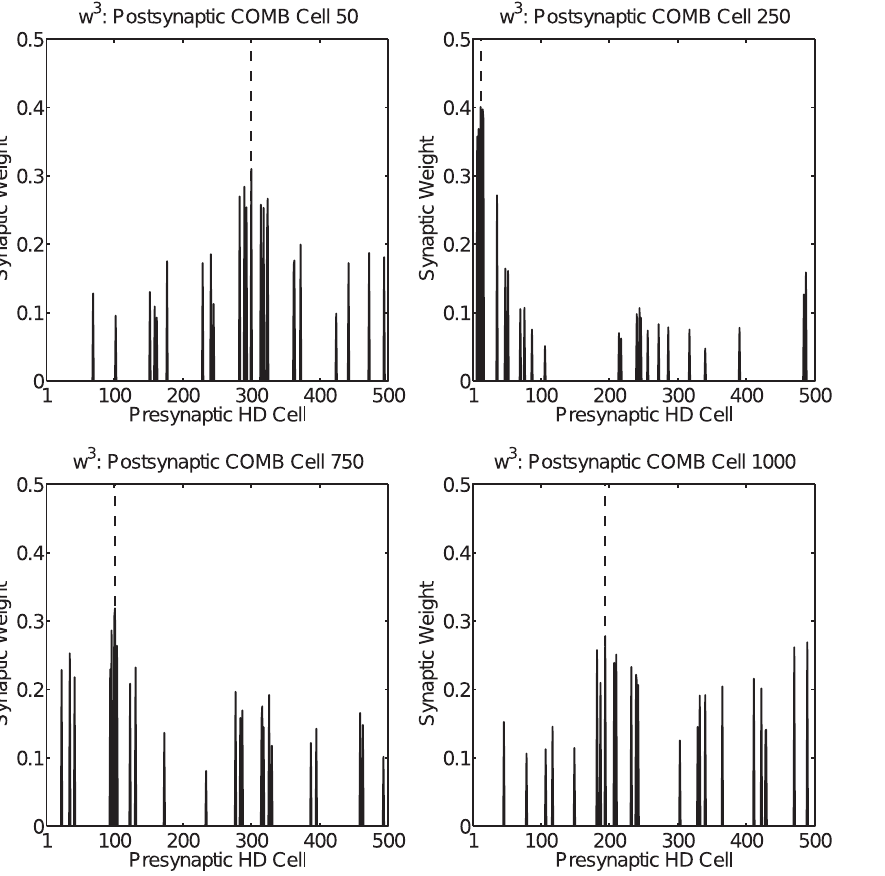
Figure 4. The synaptic weights w 3 from the Head Direction (HD) cell network to the Combination (COMB) cell network after competitive learning with the time-delayed Hebbian associative learning rule (9) and weight normalization (13). These results are from a simulation with an axonal conduction delay of 100 ms, and a rotational velocity during training of 180 0 = sec (all other parameters are as given in Table 1). Each of the four plots shows the learned synaptic weights to a different postsynaptic COMB cell from the 500 presynaptic HD cells. The presynaptic HD cells are arranged in the plots according to where they fire maximally in the head-direction space of the agent when visual input is available. For each plot, a dashed vertical line indicates the presynaptic HD cell with which the postsynaptic COMB cell has maximal w 3 synaptic weight. Except for the effects of diluted synaptic connectivity, each of the weight profiles is centred on a region of similarly-tuned HD cells, with a profile that is approximately symmetric about the presynaptic HD cell with maximal synaptic strength. Thus, the learned w 3 synaptic weights show that individual COMB cells learn to receive maximal stimulation from particular head direction cells. Given that the model parameters w 3 , w 4 , and the threshold a of the COMB cell sigmoid transfer function are tuned to ensure that a strong rotational velocity cell input through the w 4 synapses is also needed in order to fire the COMB cells, these cells in fact learn to respond to combinations of a particular head direction and clockwise or counter- clockwise rotational velocity. input. During the time interval 0.0–2.25 seconds, the agent rotated (compared to the w 3 synapses), the activity packet in the in a clockwise direction. During the time interval 2.25–4.5 combination cell network stimulated head direction cells repre- seconds, the agent rotated in a counter-clockwise direction. The senting head directions further along in the clockwise direction of top right plot displays the firing rates of the head direction cells rotation. Thus the head direction cell activity packet moved during testing in the absence of visual input. During the time through the head-direction space of the agent, and the model interval 0.0–1.0 seconds, there was no firing in the rotational performed velocity path integration of head direction. During the velocity cells (bottom left plot) and consquently no firing in the time interval 2.0–3.0 seconds, the rotational velocity cells, and thus combination cells (bottom right plot); thus there was a stable the combination cells, were quiescent in their firing and a stable packet of head direction cell activity supported by the w 1 recurrent packet of activity remained in the head direction cell network. synapses. During the time interval 1.0–2.0 seconds, the 250 During the time interval 3.0–4.0 seconds, the 250 rotational rotational velocity cells representing clockwise rotation became velocity cells representing counter-clockwise rotation became active (bottom left), which in turn stimulated an activity packet in active (bottom left) and thus stimulated an activity packet in the combination cell network (bottom right). In an identical mecha- the network of combination cells through the w 4 synapses in nism to that for clockwise rotation, the model thus performed conjunction with the head direction cell input through the w 3 velocity path integration of head direction, but this time in the synapses (bottom right). Due to the axonal conduction delays D t counter-clockwise direction of rotation. During the time interval and the asymmetry in the weight profiles of the w 2 synapses